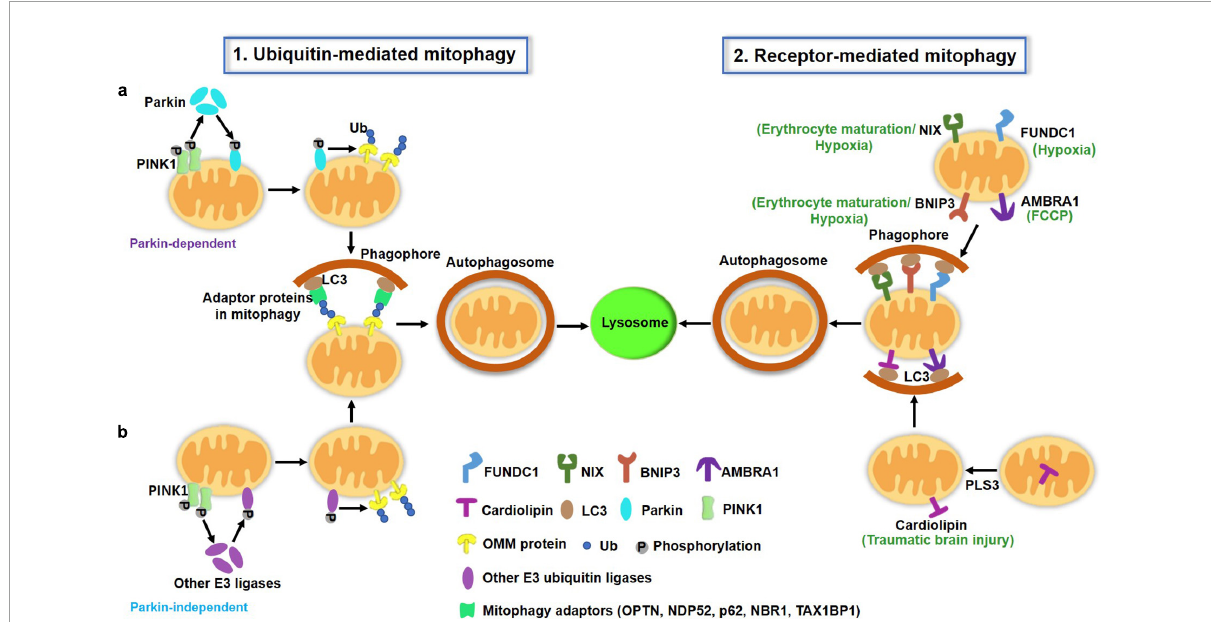
FIGURE1 A schematic illustration of two major pathways of mitophagy in mammalian cells. (1) Ubiquitin (Ub)-mediated mitophagy pathways. PINK1 accumulates on the OMM of depolarized mitochondria and undergoes auto-phosphorylation. (a) PINK1 then recruits cytosolic Parkin translocation to the OMM and activates this E3 Ub ligase by phosphorylation, which ubiquitinates several OMM proteins such as mitofusin, VDAC and Miro. PINK1 also directly phosphorylates the preexisting Ub on the OMM. Ub is also able to recruit and activate Parkin. The actions of PINK1 and Parkin cooperatively lead to the polyUb process of damaged mitochondria, which can be recognized by mitophagy adaptors (p62, OPTN, NDP52, NBR1, TAX1BP1) to mediate mitochondria sequestrated by autophagosomes. (b) Apart from Parkin, other E3 ubiquitin ligases [ARIH1, seven in absentia homolog (SIAH)-1 and RNF34, etc.] have been reported to mediate mitophagy in a PINK1-dependent manner. (2) Receptor-mediated mitophagy. OMM proteins including FUNDC1, AMBRA1, BNIP3L/Nix, BNIP3 serve as mitophagy receptors under specific conditions (hypoxia, erythrocyte maturation, and toxin exposure). These receptors directly bind to LC3 via the LIR motif. Additionally, a few IMM proteins such as cardiolipin and prohibitin 2 can translocate to the OMM under certain conditions, where they also serve as mitophagy receptors and promote mitophagy through their LIR to interact with LC3 on the autophagosomes. OMM, outer mitochondrial membrane; IMM, inter mitochondrial membrane; LIR, LC3-interacting